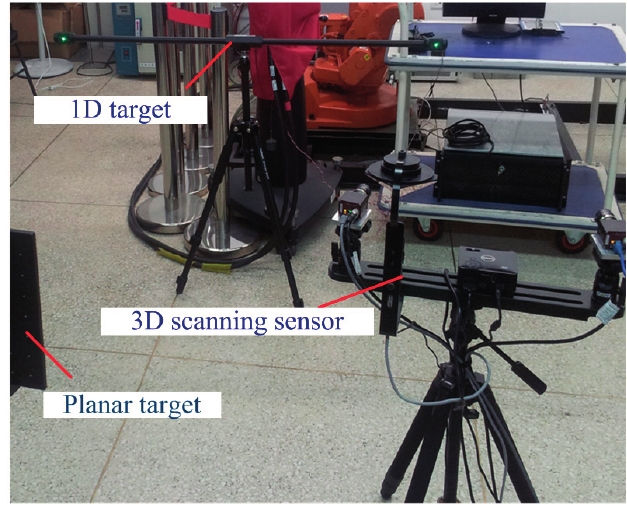
Figure 9. Schematic of global measurement precision evaluation.